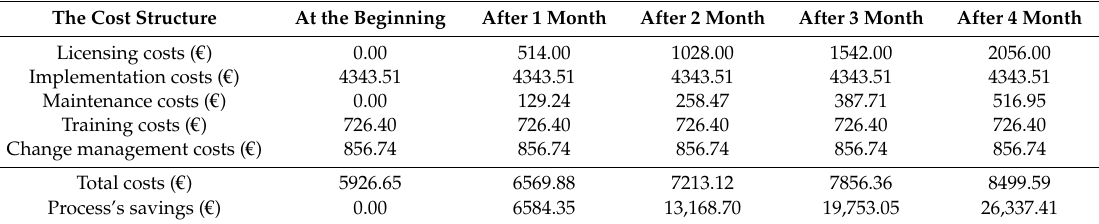
Table 3. The cost structure of the digital process transformation and potential